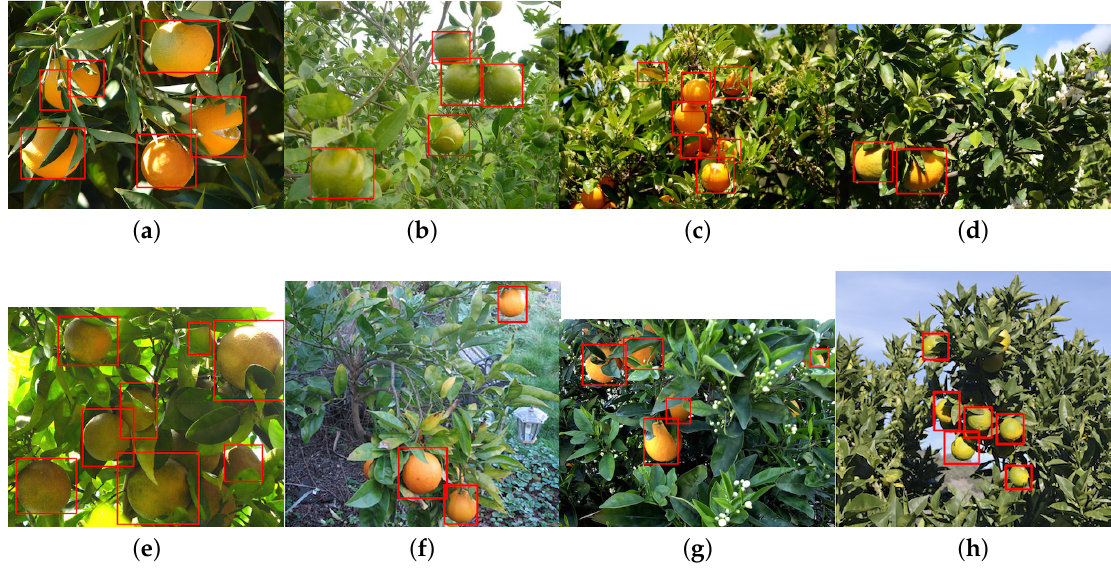
Figure 20. Eight instances ( a – g ), and ( h ) of orange detection (varying levels of ripeness). Images are obtained from Google Images.